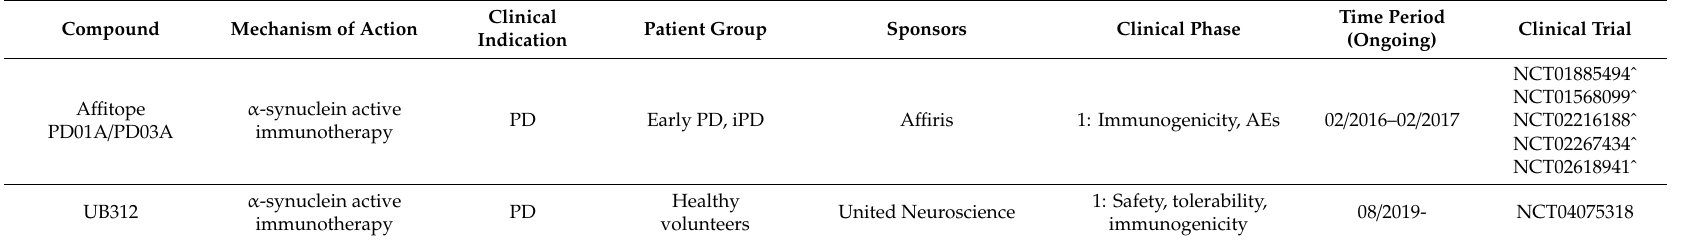
Table 1 Alpha-synuclein (AS)-based disease-modifying treatment strategies and their current progress in clinical trials. iPD = idiopathic PD, * Repurposed drugs, ˆ completed clinical trial, AEs = adverse e ff ects, PK = pharmacokinetics, PD = pharmacodynamics; Clinical phases: 1 = Phase 1, clinical trials that focus on drug safety typically conducted with healthy volunteers